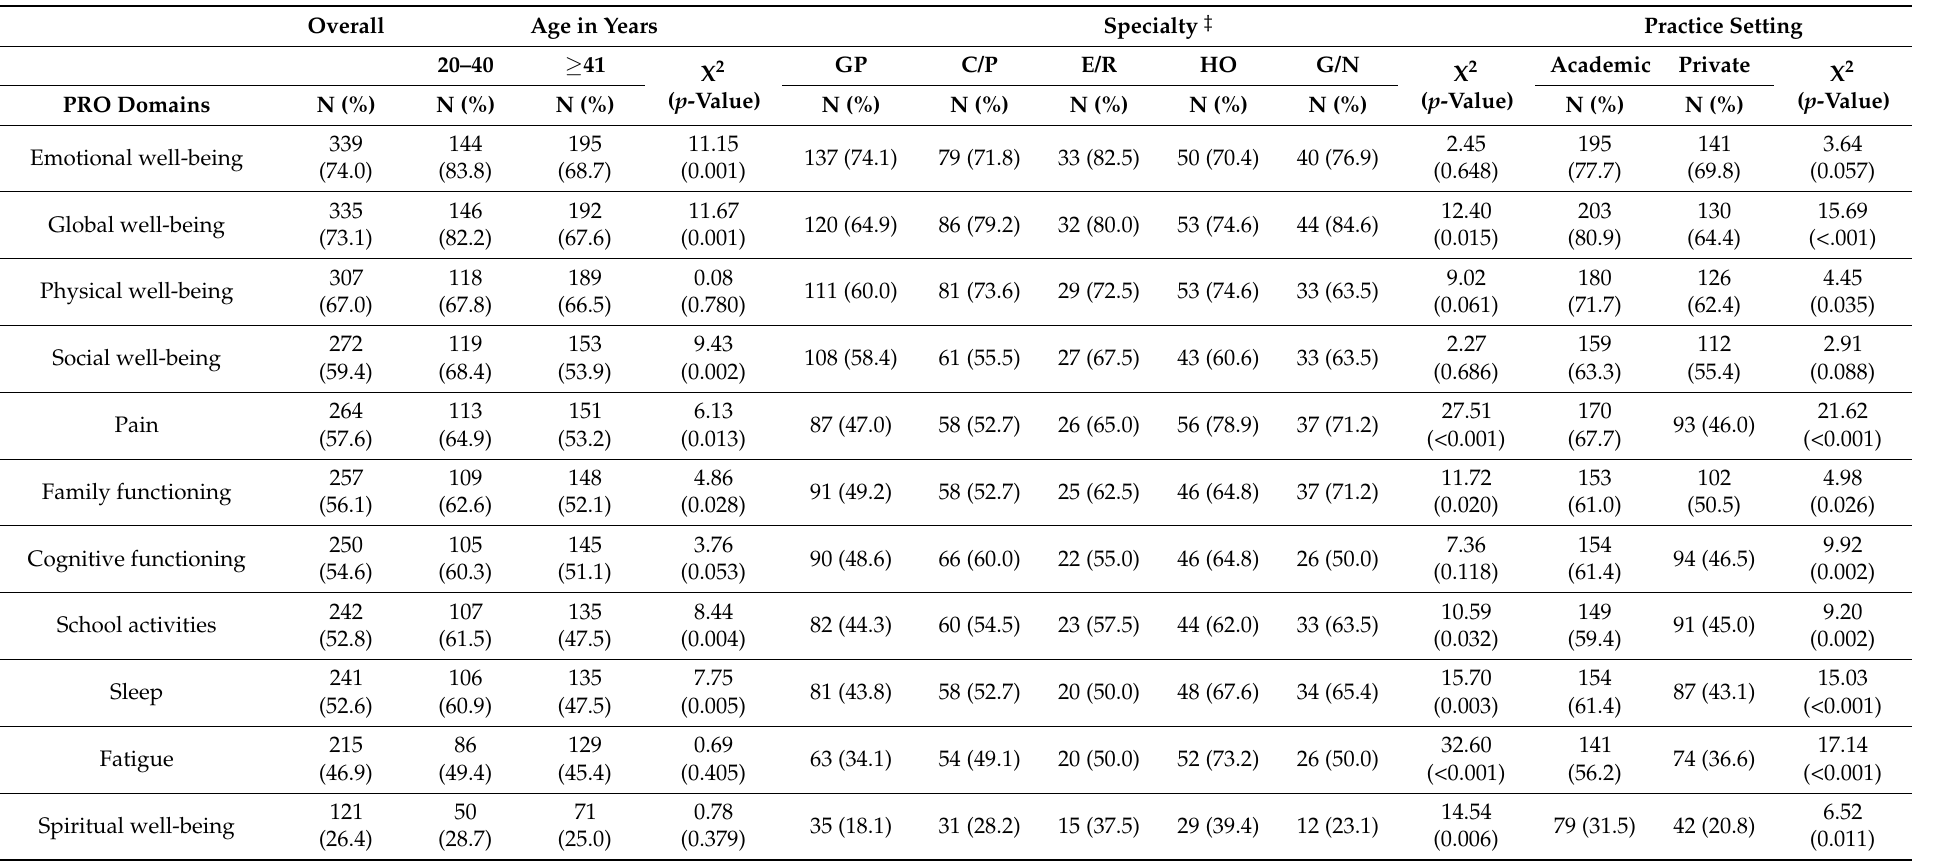
Table 2. Important PRO Domains for Assessment Associated with Pediatricians’ Age, Specialty, and Practice Setting †